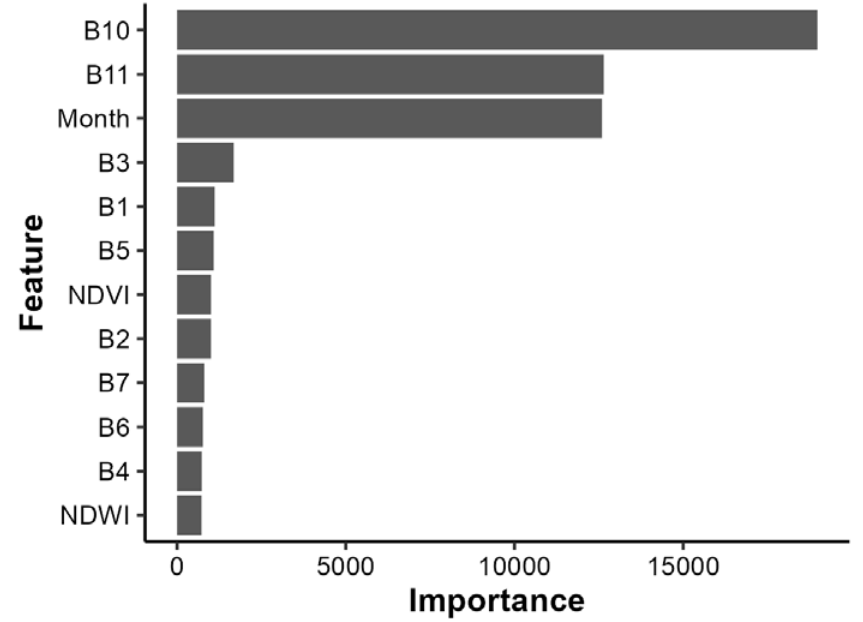
Figure 7. Feature importance using impurity